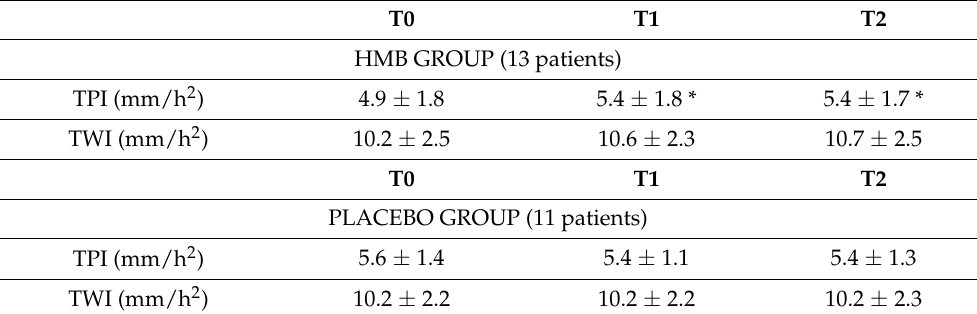
Table 3. Changes in quadriceps thickness across the study according to ultrasounds.